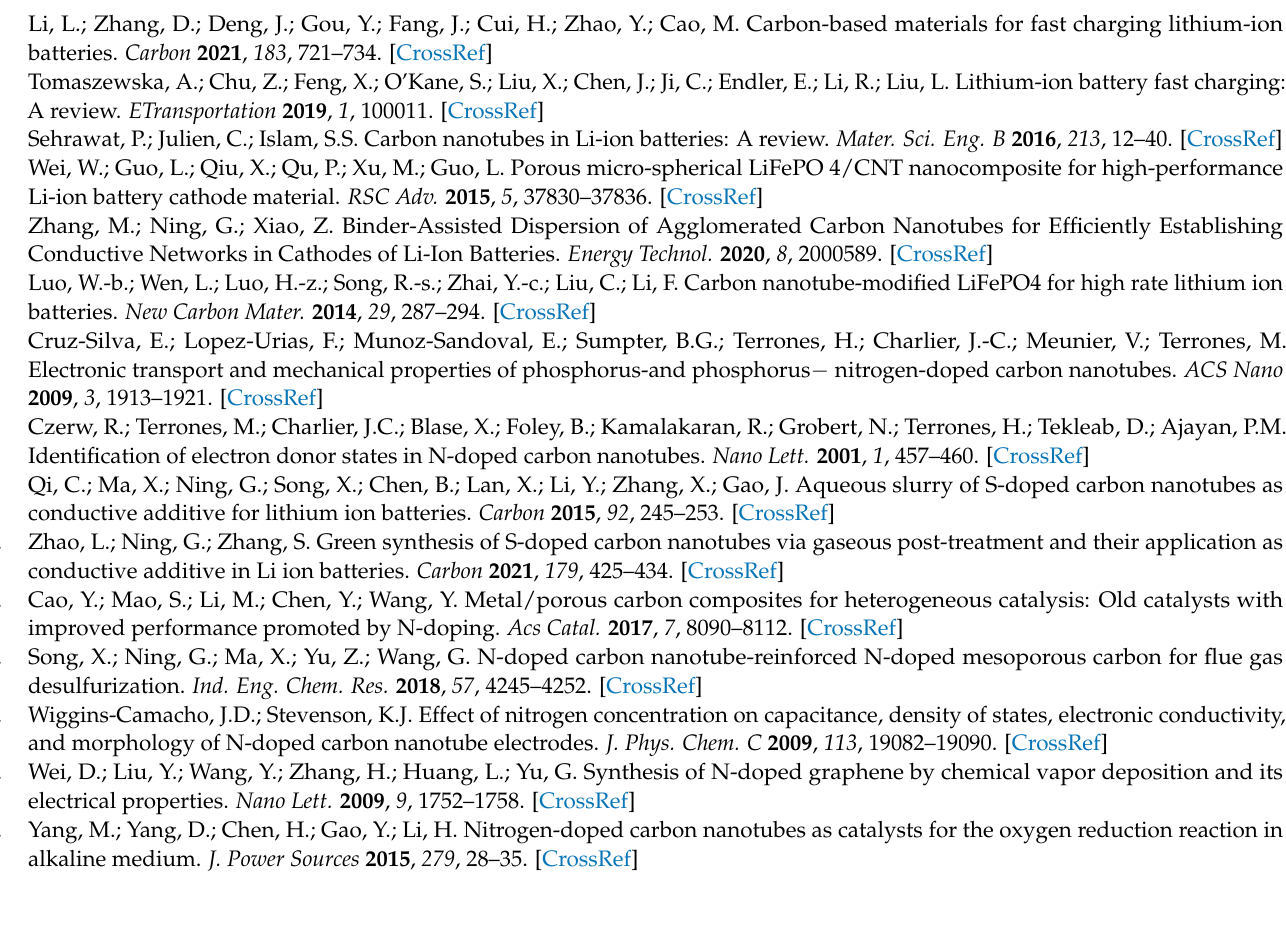
different cycling rates; title. Figure S2: Energy efficiency of bat-teries at different cycling rates. Figure S3a–f: CV curves of the B-NCNT-800 (a) and B-CNT (b) cells for second to third cycles at a scan rate of 0.1 mV s-1 over the potential range of 3.0–4.3 V, the CV curves at diverse scanning rates of the B-NCNT-800 (c) and B-CNT(d), use of eq 1 to ana-lyze the CV data for the B-NCNT-800 and B-CNT(e), and the use of eq 2 to analyze the CV data for the B-NCNT-800 and